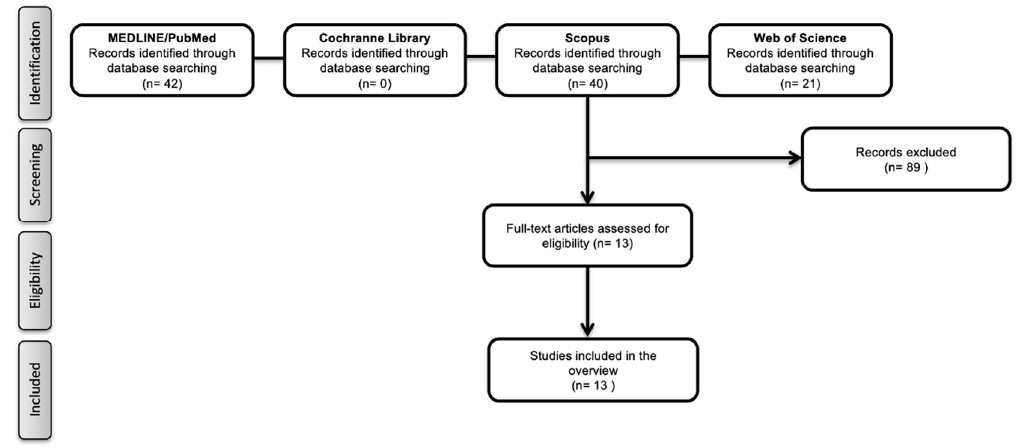
Figure 1. Flow diagram (PRISMA format) of the screening and selection process.